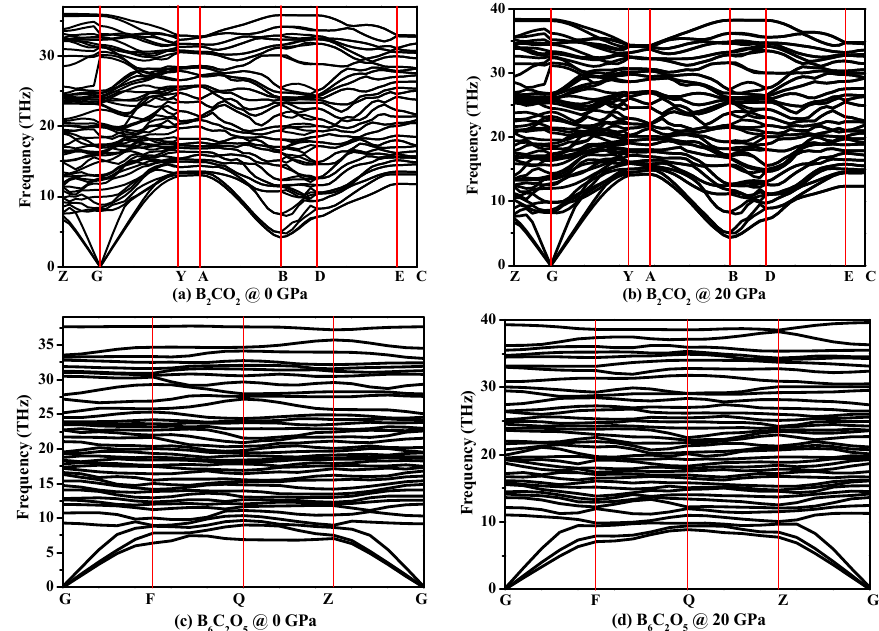
Figure 3. Phonon spectra of B 2 CO 2 and B 6 C 2 O 5 under different pressures: B 2 CO 2 @ 0 GPa ( a ); B 2 CO 2 @